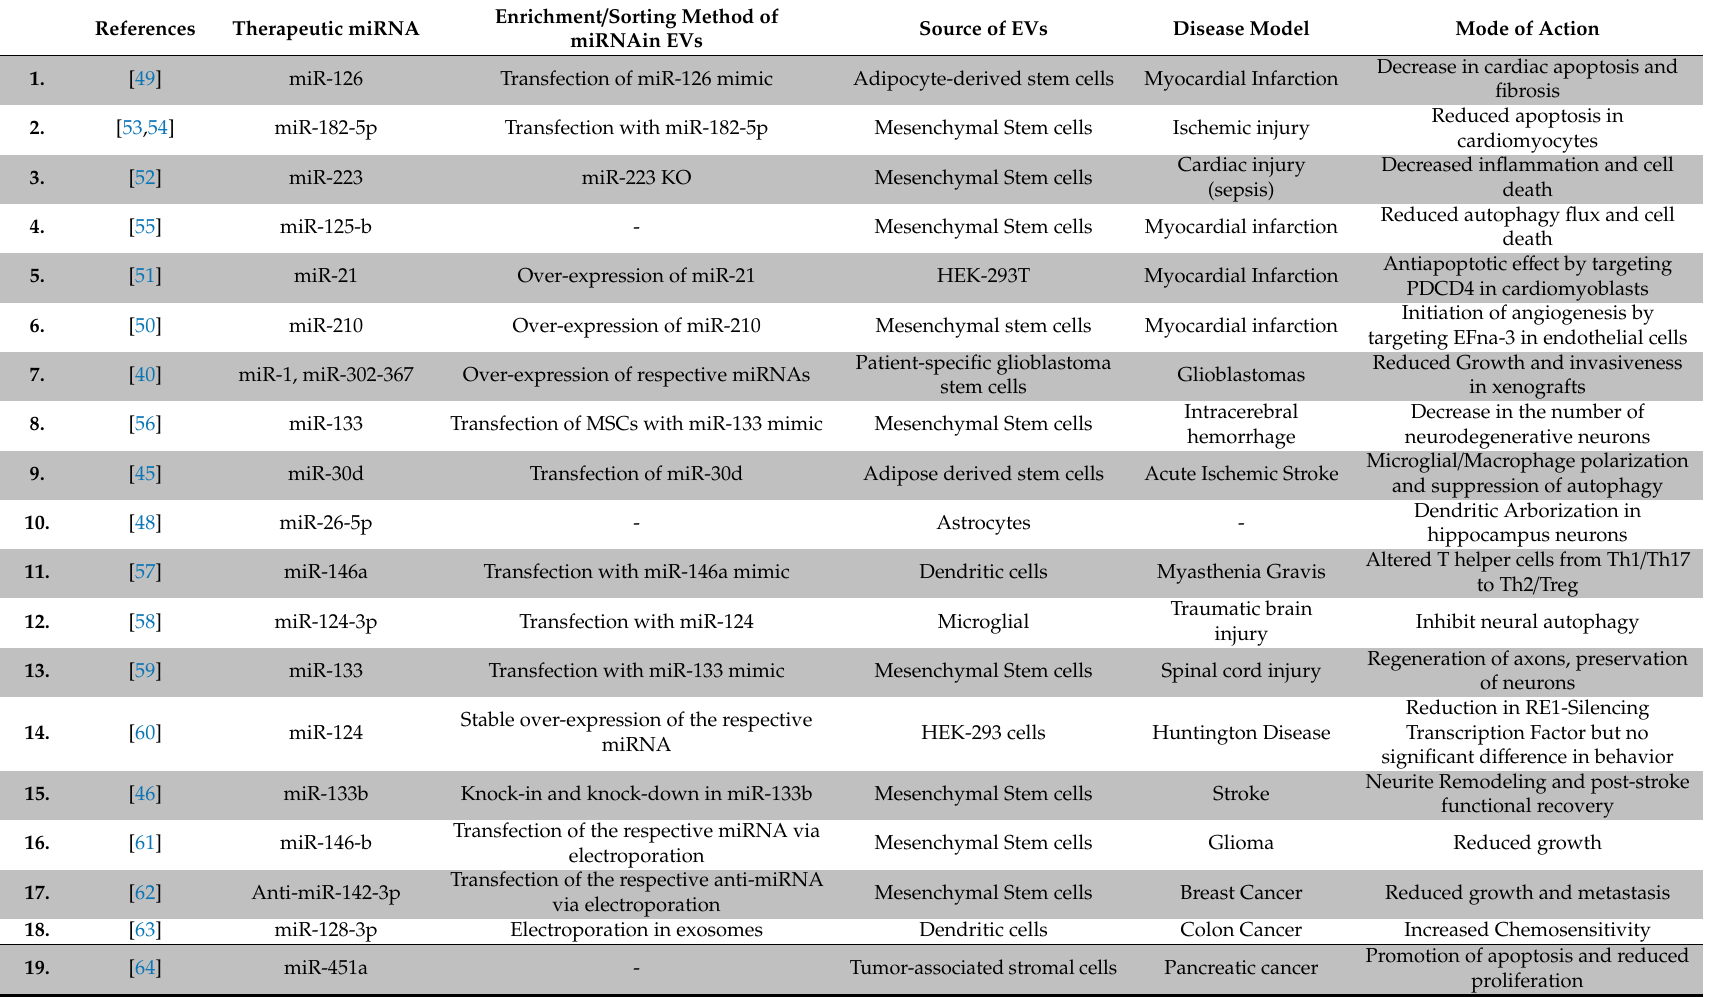
Table 1. Therapeutic miRNA-enriched EVs: Evidence from Disease